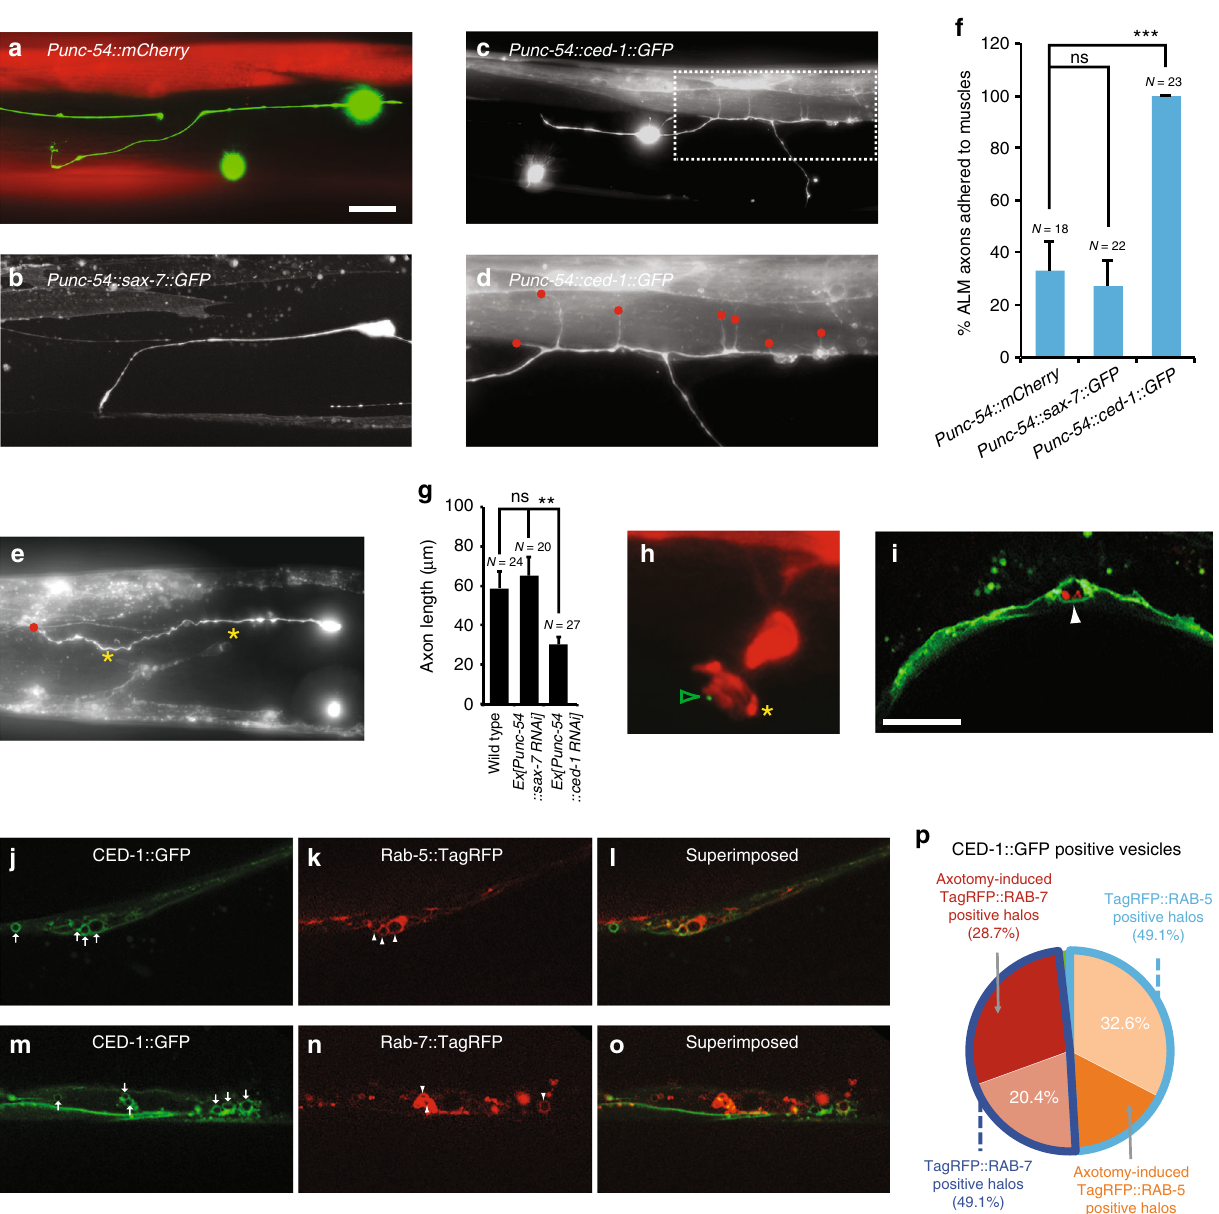
Fig. 3 CED-1 from the muscle-type engul fi ng cell is adhesive to regenerating axons and mediates axon debris phagocytosis. a – f Regenerating ALM axons were adhered to muscles overexpressing CED-1. Representative images were taken in young adult stage 24 h after injury ( a – e ). Anterior is to the left; dorsal is up. Scale bar: 20 μ m. a The ALM axon in wild-type animals expressing the Punc-54::mCherry transgene was not adhered to muscles. b The ALM axon in wild-type animals expressing the Punc-54::sax-7 transgene was not adhered to muscles. c – e ALM axons in wild-type animals expressing the Punc- 54::ced-1 transgene were adhered to muscles. The dashed box area in ( c ) was blown up in ( d ). Red dots in ( d ) and ( e ) indicate regenerating axon endings at muscles and yellow asterisks in ( e ) mark muscle protrusions. f The percentages of regenerating ALM axons adhered to muscles. The N number represents the number of animals analyzed. Error bars represent SEP. Asterisks represent P < 0.001 by Z -test for two proportions. g Average length of regenerating ALM axons. The muscle-speci fi c knockdown of ced-1 caused reduced axon regeneration. Axons were visualized using the zdIs4[Pmec-4::GFP] marker. ns indicates no signi fi cant difference. Error bars indicate SEM. ** p < 0.01. P values were calculated using a Student ’ s t -Test. h Axon debris were labeled by the Pmec-4::GFP transgene and muscle protrusions were labeled by the Punc-54::ced-1::mRFP reporter. The green open arrowhead and the asterisk point to axon debris and the muscle protrusion, respectively. i Axon debris were labeled by the Pmec-4::myr::mCherry transgene and body wall muscles were labeled by the Punc-54::ced-1::GFP reporter. The white arrowhead points to a phagosome encircling axon debris. Images were taken in young adult stage 4 h after axotomy for axon debris ( h and i ). Scale bar: 10 μ m. j and m CED-1::GFP-expressing vesicles in muscle cells. Early phagosomes ( k ) and late phagosomes ( n ) in muscle cells were labeled by the Rab-5::TagRFP and the Rab-7::TagRFP, respectively. l and o Superimposed images. Arrows indicate CED-1::GFP- expressing vesicles whereas arrowheads mark either Rab-5::TagRFP-positive halos ( k ) or Rab-7::TagRFP-positive halos ( n ). p The percentages of CED-1:: GFP positive vesicles that are also positive for either Rab-5::TagRFP or